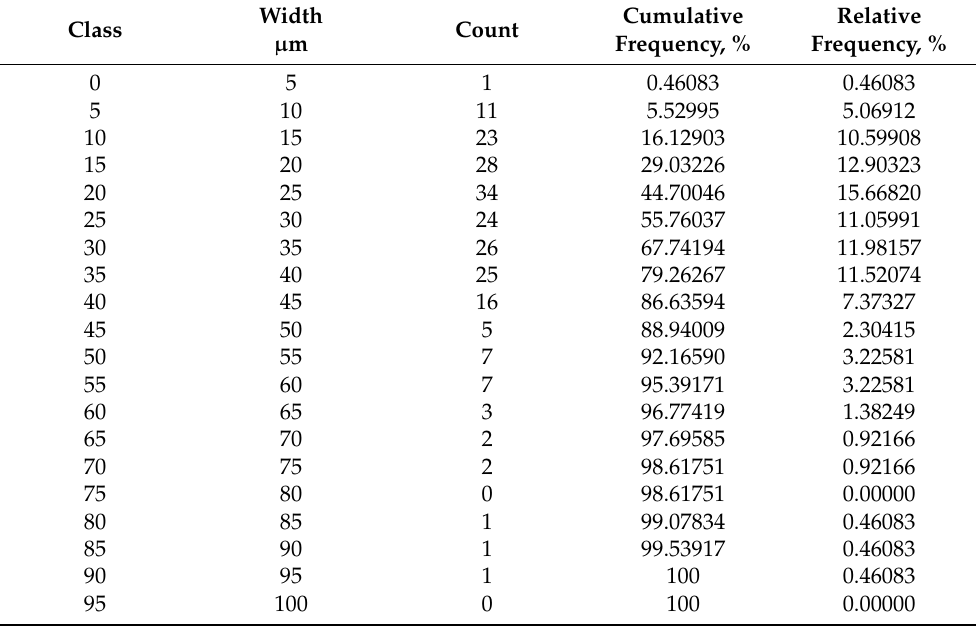
Figure 4. The measurement line of the dendritic crystals’ medium width. Table 2. Width of the dendritic crystals in the hard-faced layer deposited by the DUR 600-IG filler